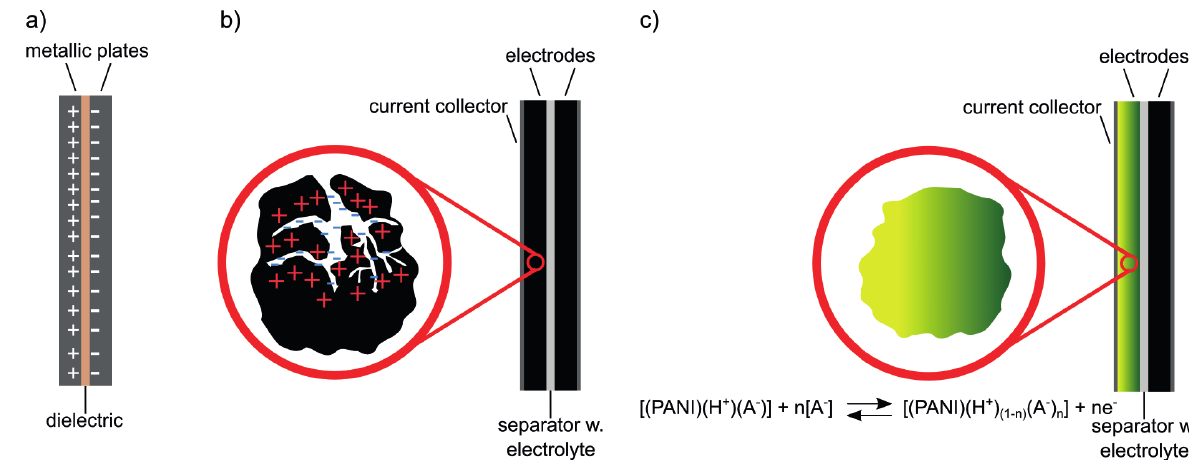
Figure 2. (a) electrostatic capacitor, (b) electrochemical double-layer capacitor, and (c) electrochemical capacitor with pseudocapacitive material (PANI as